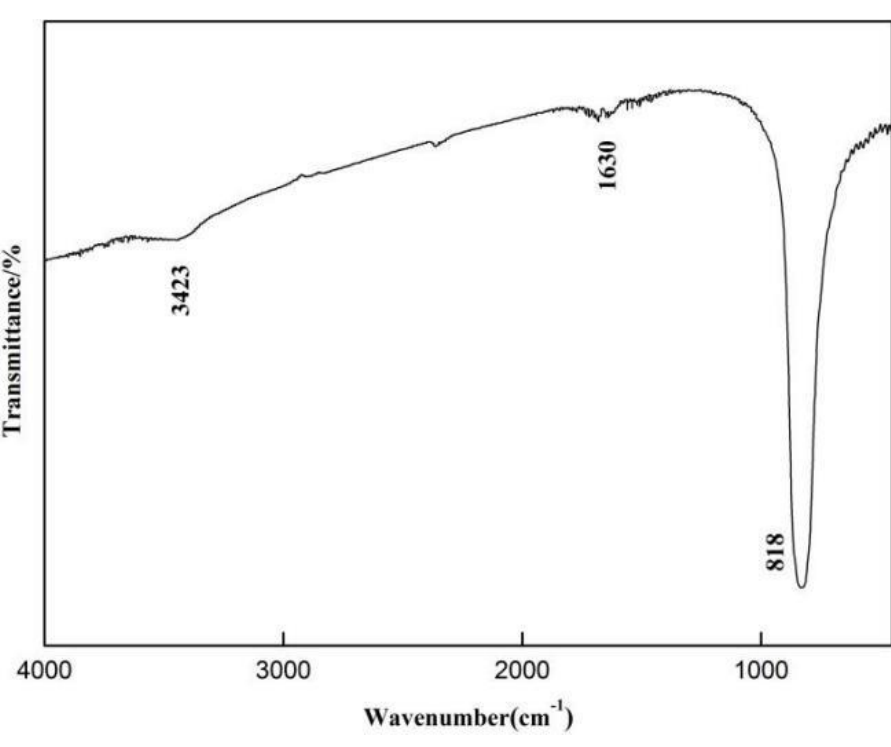
Figure 5. FT-IR spectrum of SrMo 0.5 W 0.5 O 4 sample.